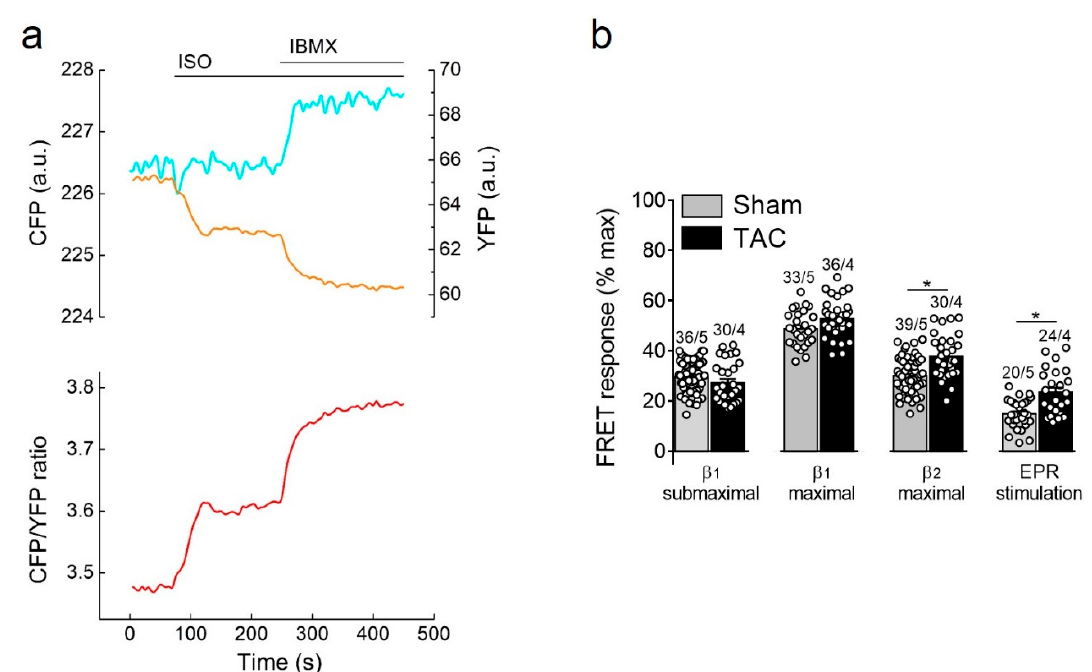
Figure 3. cAMP responses to β -adrenergic ( β -AR) and prostaglandin receptor stimulation. ( a ) Representative single CFP and YFP intensities as well as CFP/YFP ratio trace ( n = 10) recorded form a single E1-CAAX AMVM upon stimulation with isoproterenol (ISO, 100 nmol/L) and 3-isobutyl-1-methylxanthine (IBMX, 100 µmol/L). An increase in the FRET ratio represents an increase in local cAMP. ( b ) Amplitudes of cAMP response upon stimulation of β 1 -ARs (with submaximal 3 nmol/L or maximal 100 nmol/L concentration of ISO in the presence of the selective β 2 -AR blocker ICI118551, 50 nmol/L), β 2 -ARs (with 100 nmol/L ISO in the presence of the selective β 1 -AR blocker CGP20712A, 100 nmol/L) or prostaglandin EP2/4 receptors (EPR) with PGE1, 100 nmol/L. Responses to individual receptor stimulation were calculated from FRET ratio traces as a% of maximal response induced by forskolin (10 µmol/L) plus IBMX (100 µmol/L). Means ± SE. Number of cells/mice are stated above the bars. * p < 0.05 by mixed ANOVA followed by Wald’s chi-squared test.